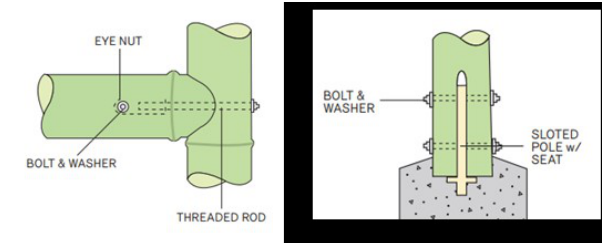
Fig. 8. Incremental House Transformation, Core House to Full Expansion Form.